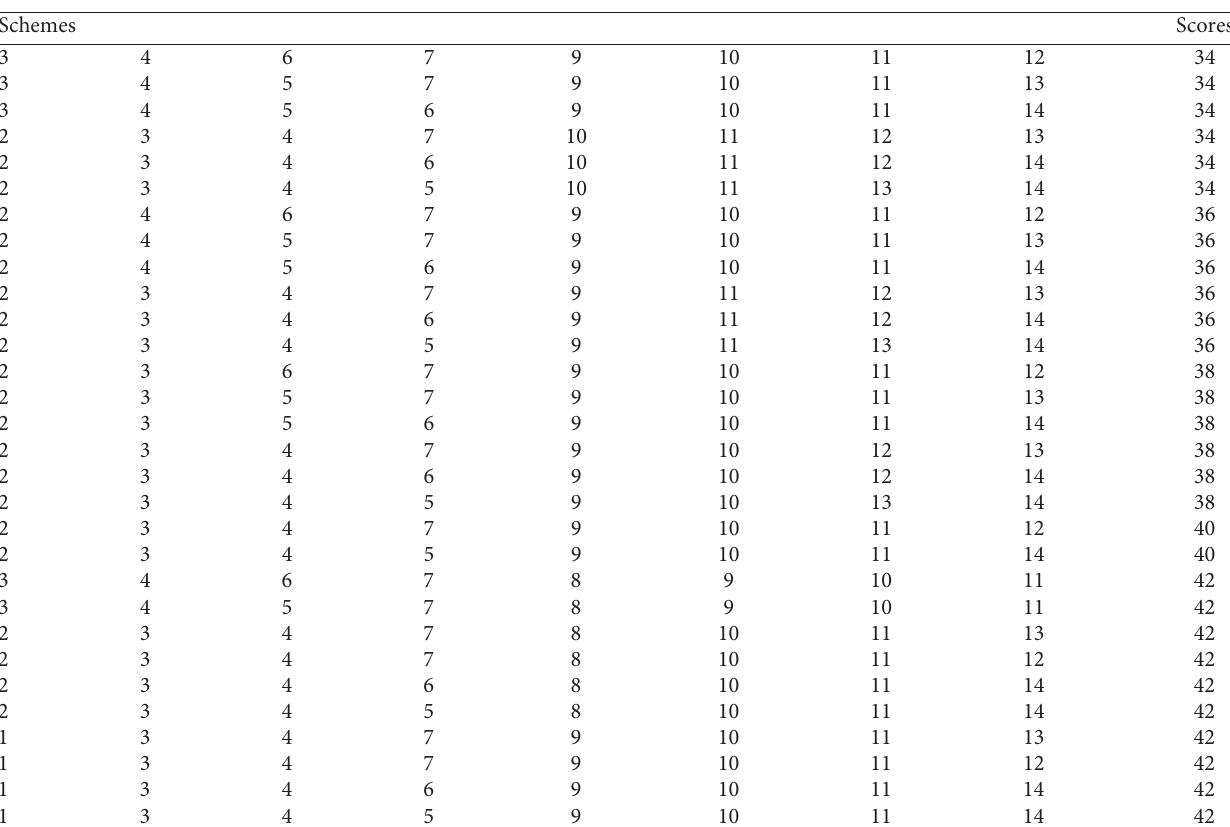
Table 2: 58 reasonable actuating input